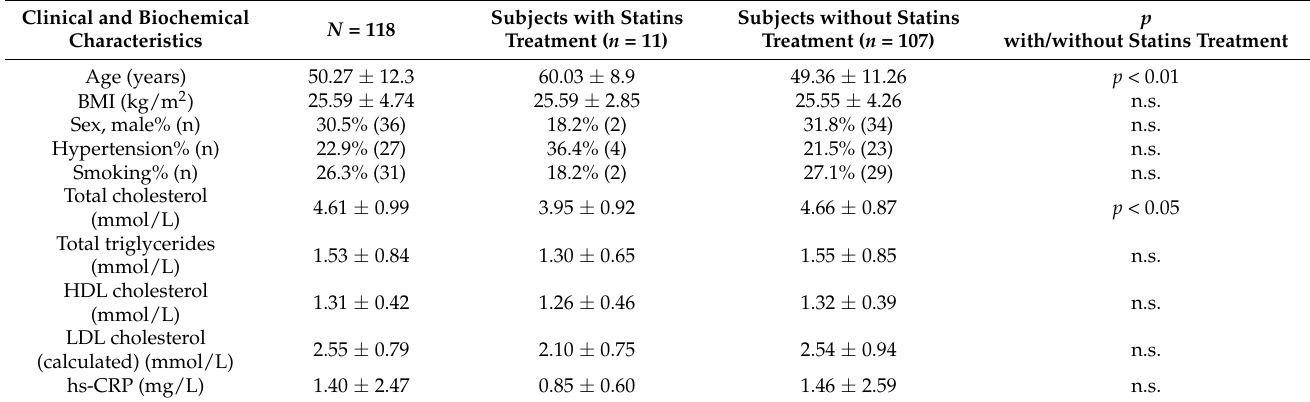
Table 1. Characteristics of all living kidney donors (LKDs) included in the study ( n = 118). n.s., nonsignificant, BMI, body mass index, HDL, high-density lipoprotein, LDL, low-density lipoprotein, and hs-CRP, high-sensitivity C-reactive protein. Clinical and Biochemical